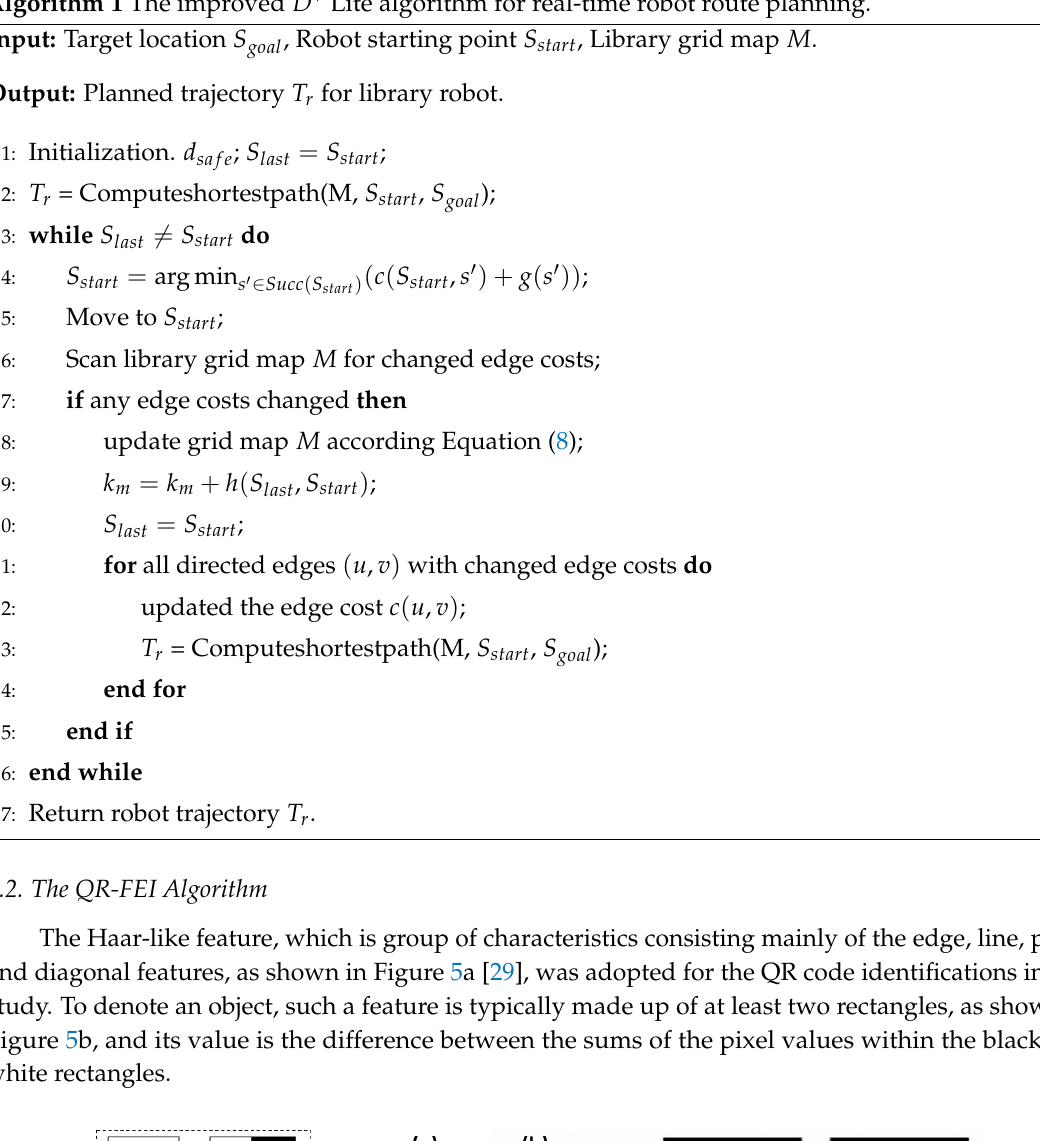
Algorithm 1 The improved D ∗ Lite algorithm for real-time robot route planning.